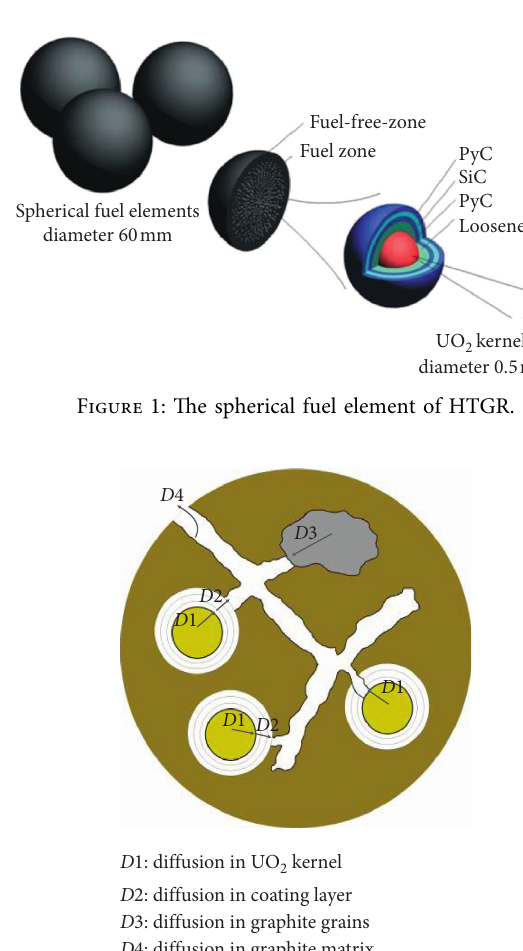
Figure 2: Diffusion model of